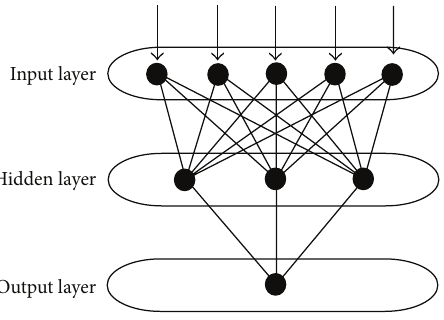
Figure 2: Multilayer neural